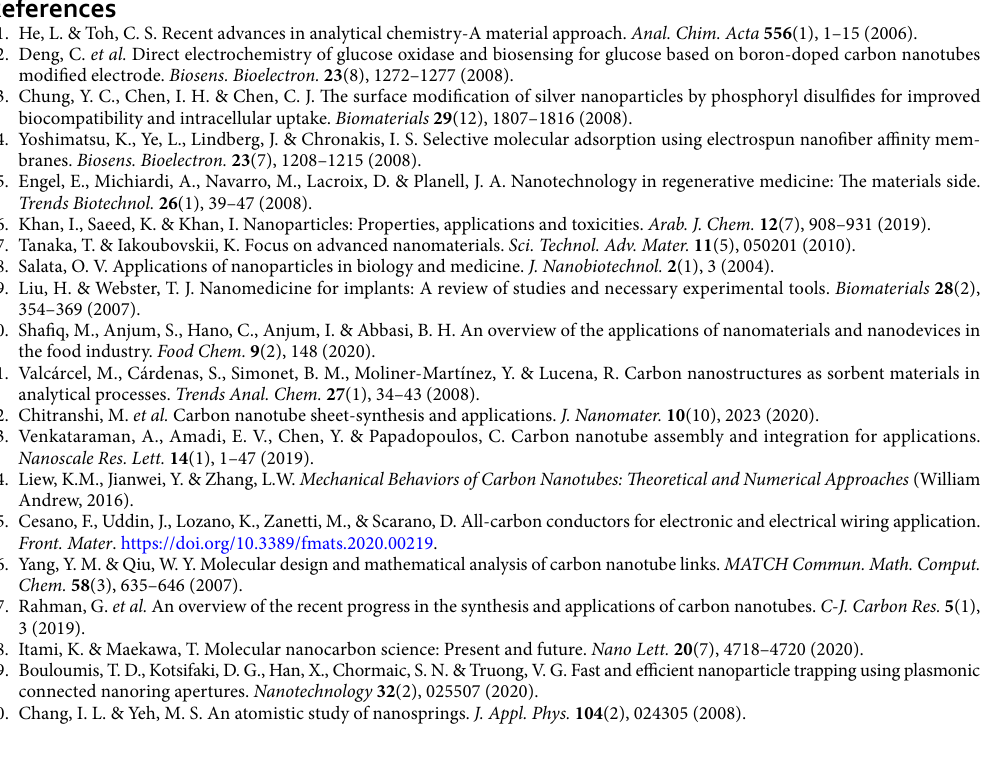
going from strong state nanomaterials to organic imaging. Also, the aromatic polymers of PPPs comprising of straightforwardly repeating benzene units as their spine. PPP has interesting optical properties, for example,